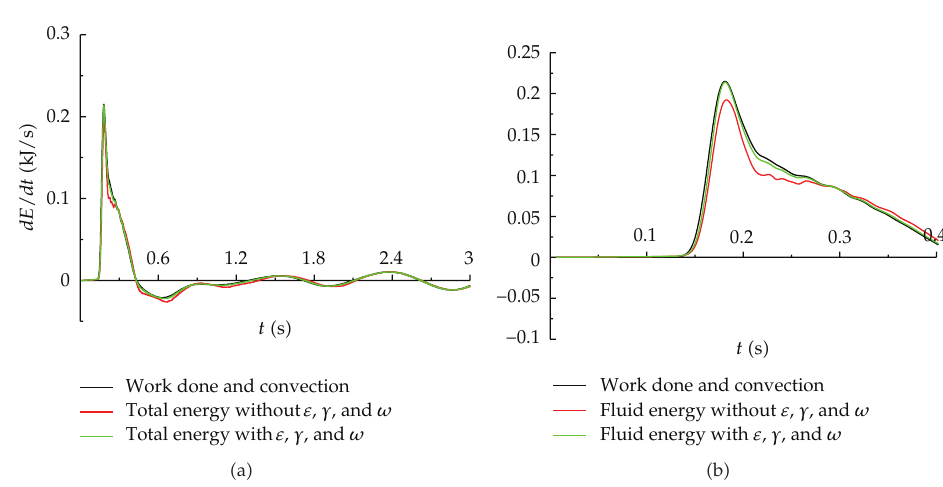
Figure 6: Time histories of numerical solutions for rate of work done and convection addition to fluid field and increase of fluid energy without or with consideration of ε , γ and ω during the whole and initial water-entry